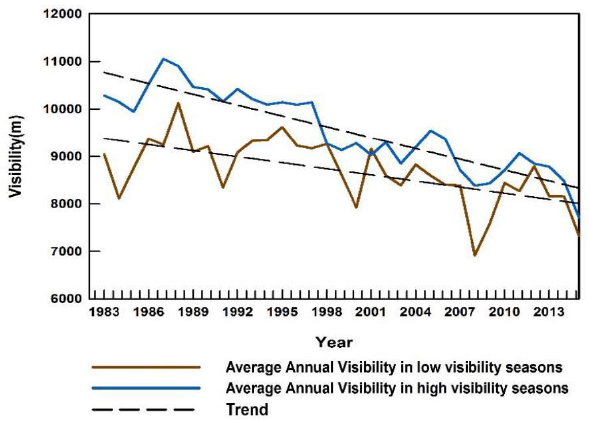
Figure 3. Trends of visibility mean values during months with records below and above the annual visibility averages in Abu Dhabi station.